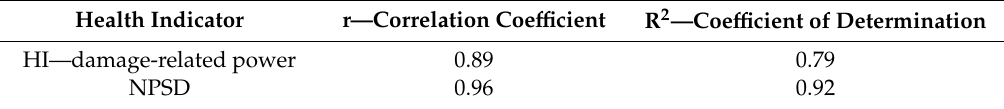
Table 5. Correlation coe ffi cients. NPSD: normalized power spectral